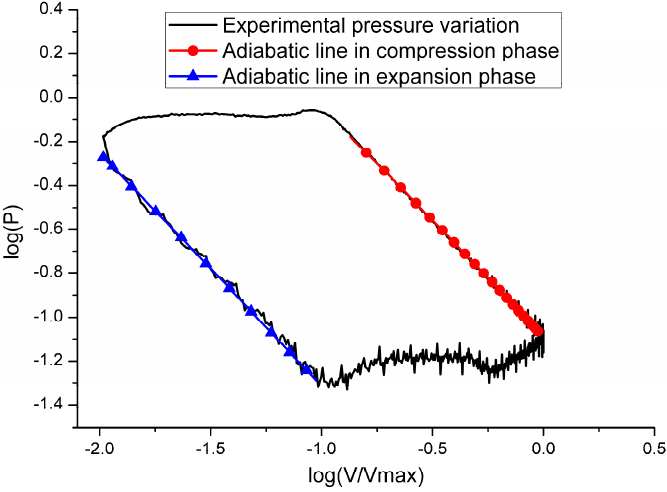
Figure 5. Comparison of experimental data and adiabatic calculation in a log( p )–log( V / Vmax ) diagram